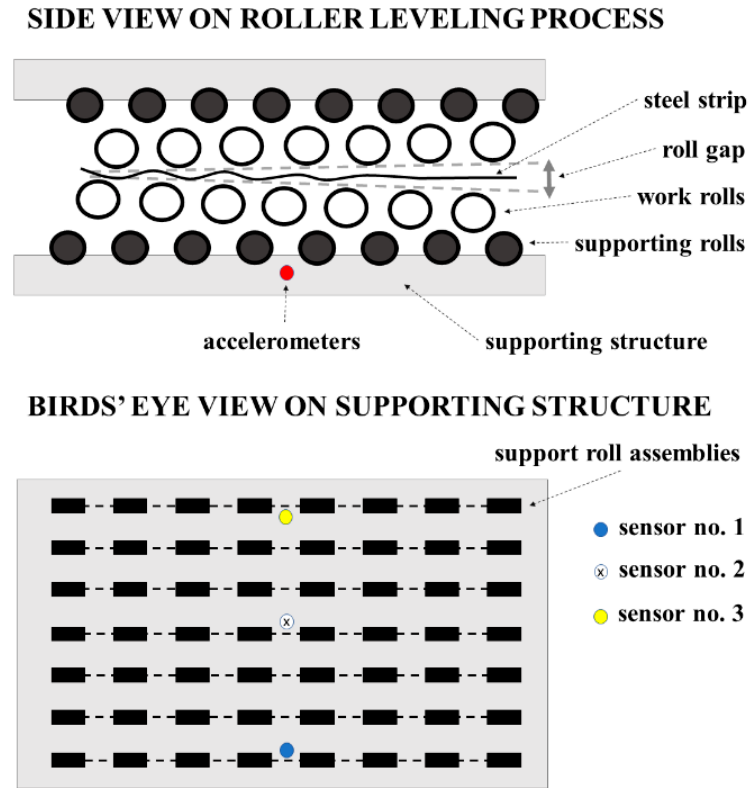
Figure 2. Drawing of roller leveling process with approximate positions of accelerometers on the supporting structure beneath the lower supporting rolls. Table 1. Information on process parameters, measurements, and computing resources in the study.